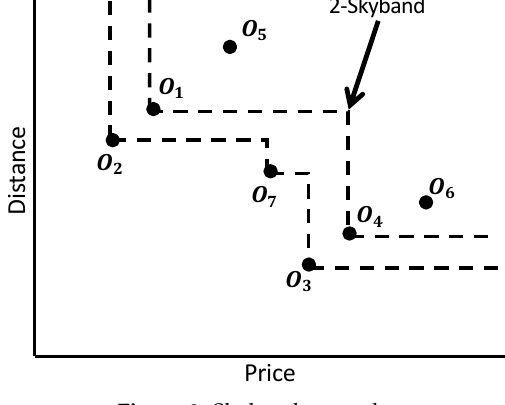
Figure 2. Skyband